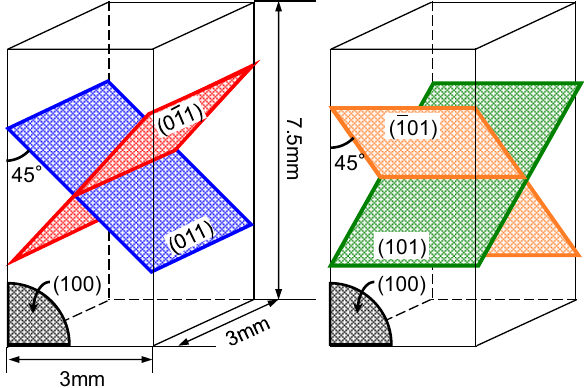
Figure 1. Schematic illustrations showing specimen shapes and available slip systems in the present deformation tests.